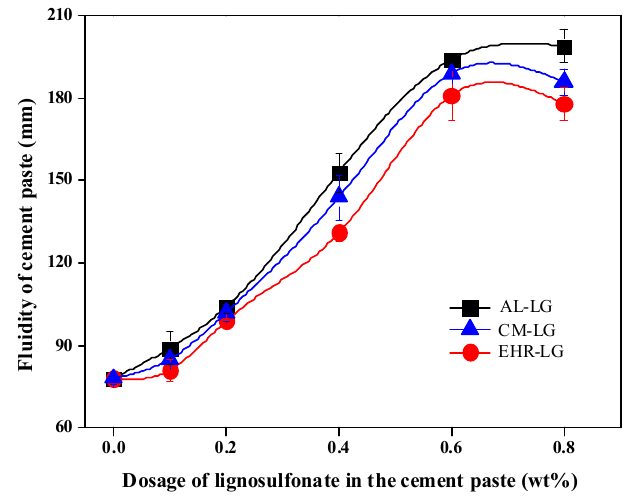
Figure 4. The effects of AL-LG, EHR-LG, and CM-LG on the fluidity of cement paste.